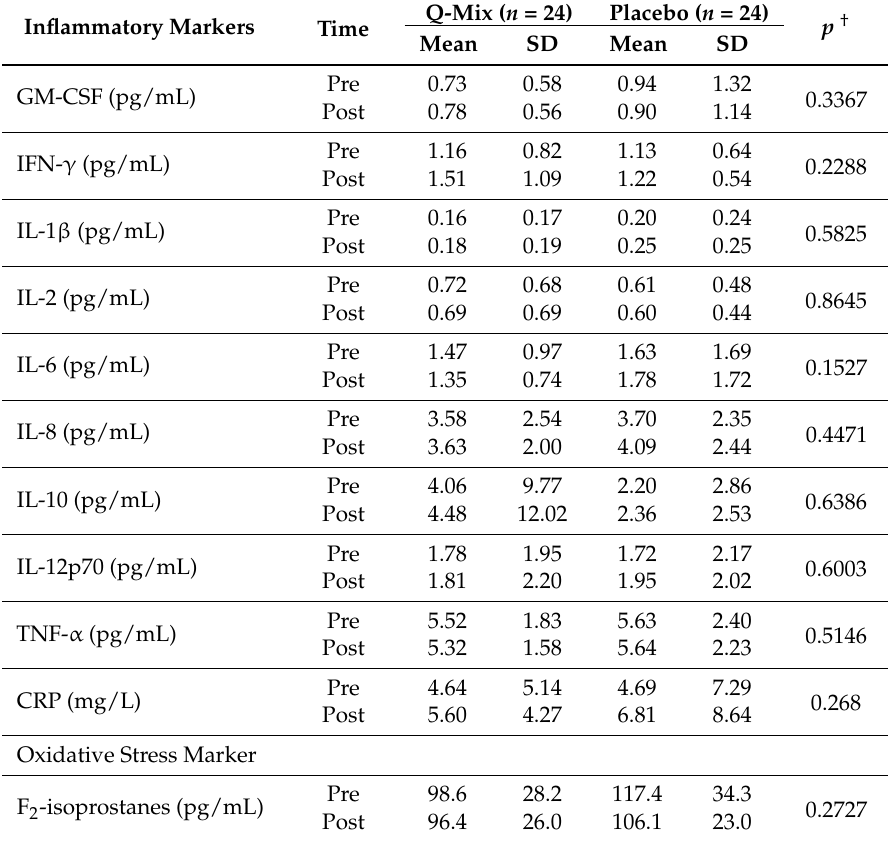
Table 2. Pre- and post-study inflammatory and oxidative stress blood markers by supplement group *. Inflammatory